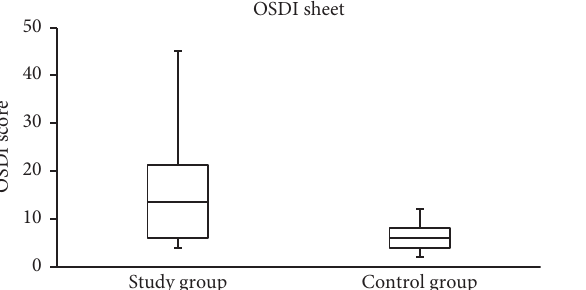
Figure 3: Side-by-side boxplots for the OSDI scores. A statistically significant difference at P < 0 . 001 (Mann–Whitney test).